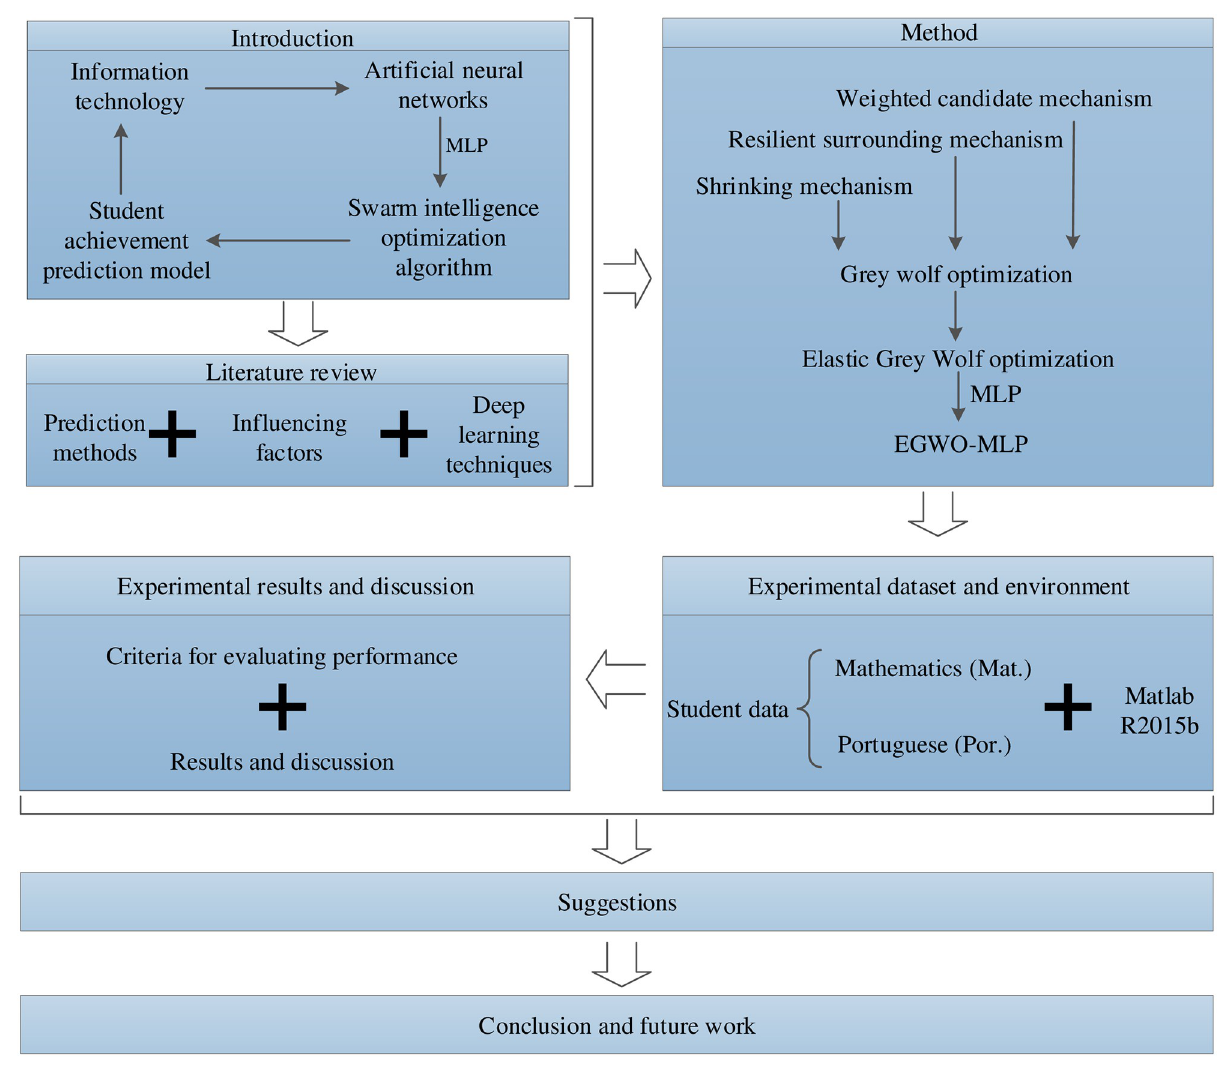
Fig 1. The full paper overall